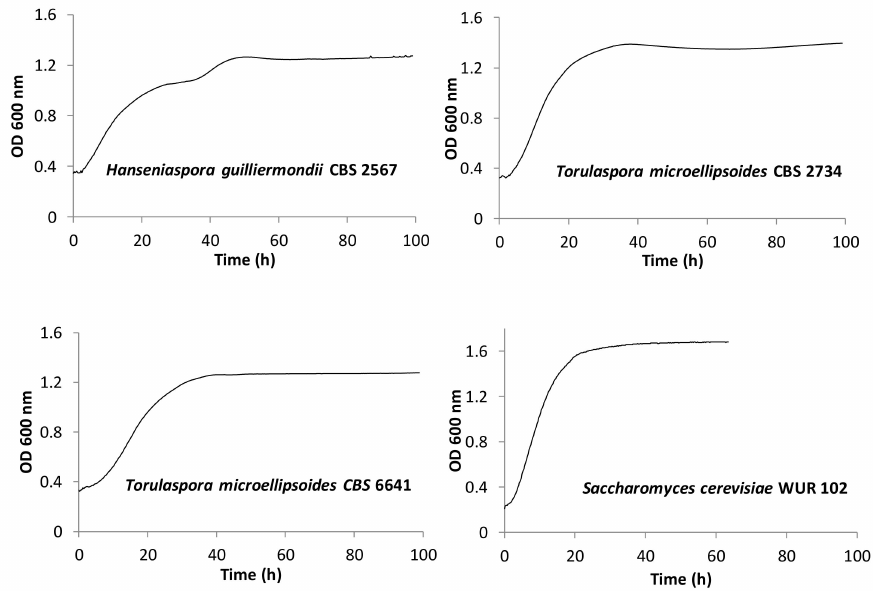
Figure 3. Kinetics of the selected strains at 25 ◦ C employing yellow cashew apple juice.